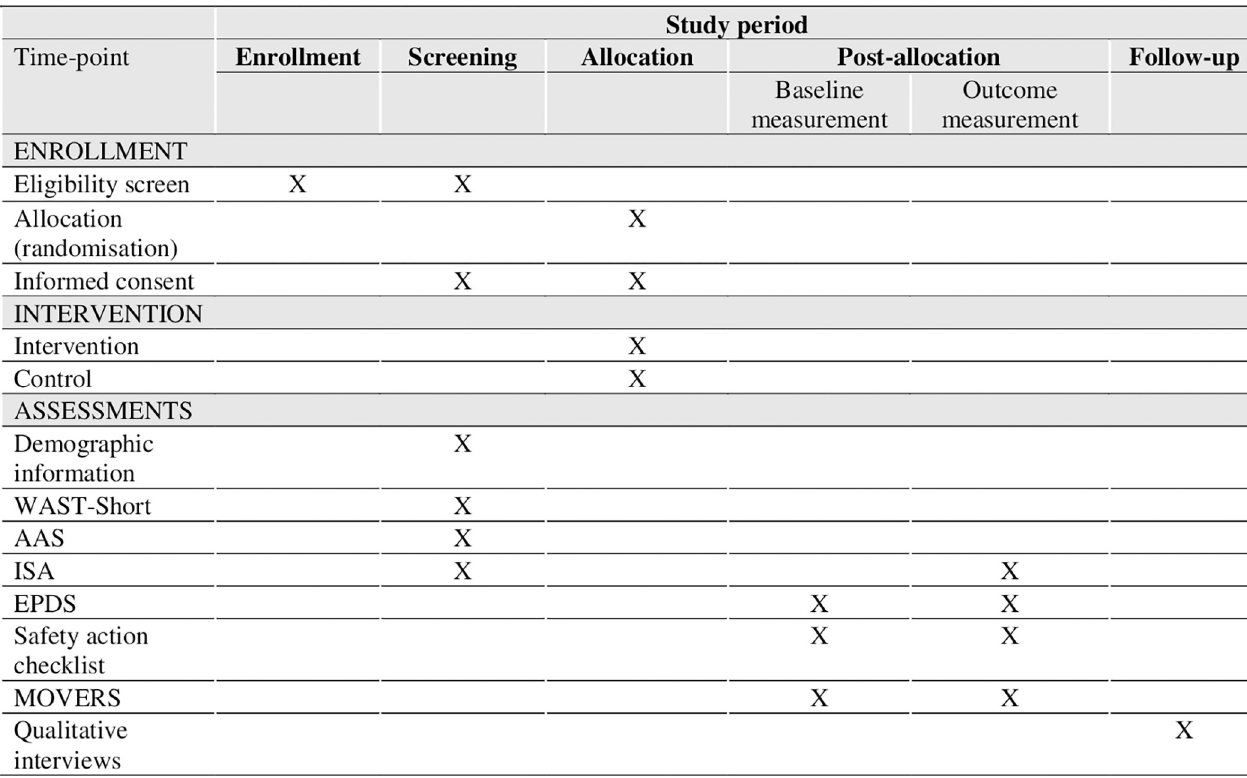
PLOS ONE | https://doi.org/10.1371/journal.pone.0282997 March 17,